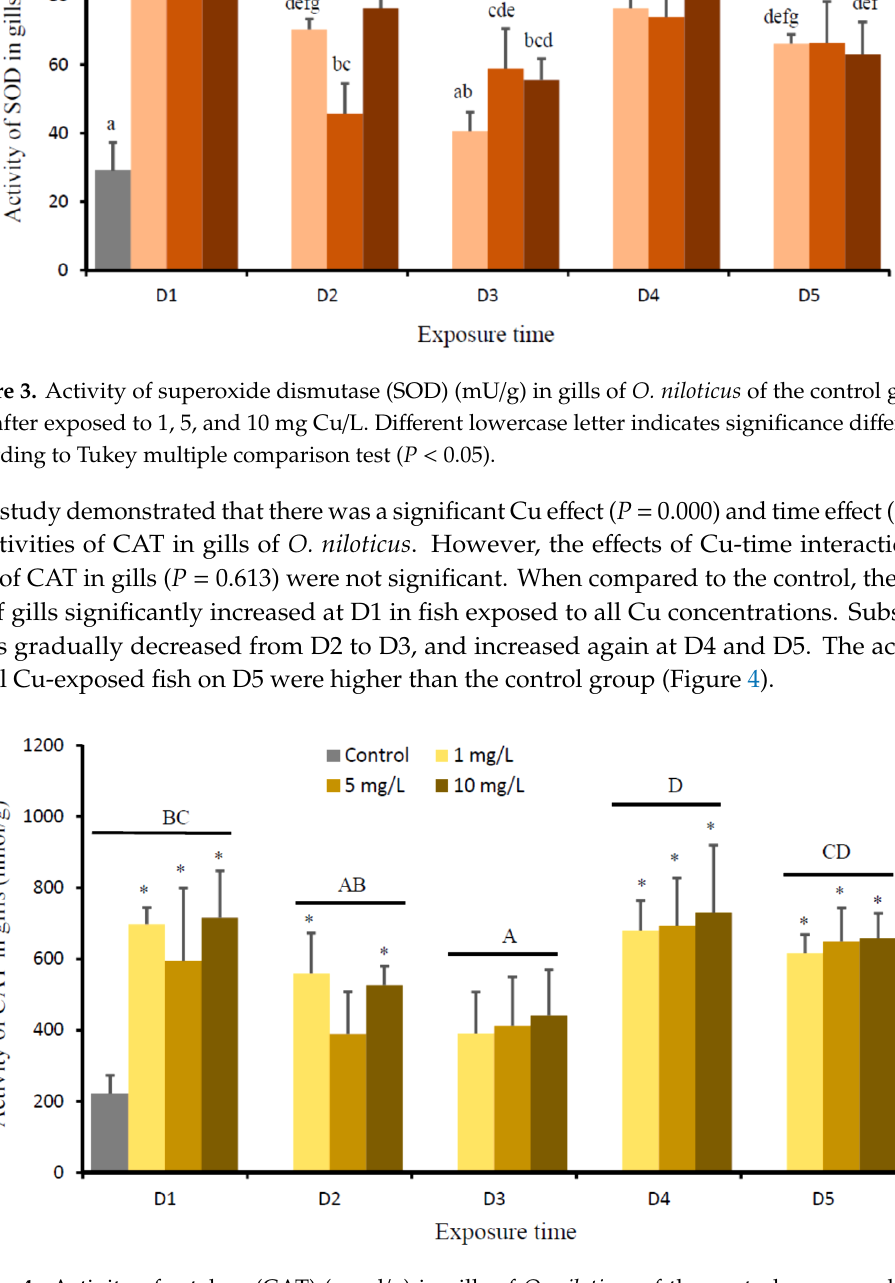
6 of 12 Figure 2. Mean concentration of metallothionein (MT) (ng/g) in gills of O. niloticus of the control group and after exposed to 1, 5, and 10 mg Cu/L. Different lowercase letter indicates significance difference according to Tukey multiple comparison test ( P < 0.05). This experiment showed that the effects of Cu ( P = 0.000), time ( P = 0.000), and Cu-time interaction ( P = 0.000) on the activities of SOD in the gills of O. niloticus were significant. The activities